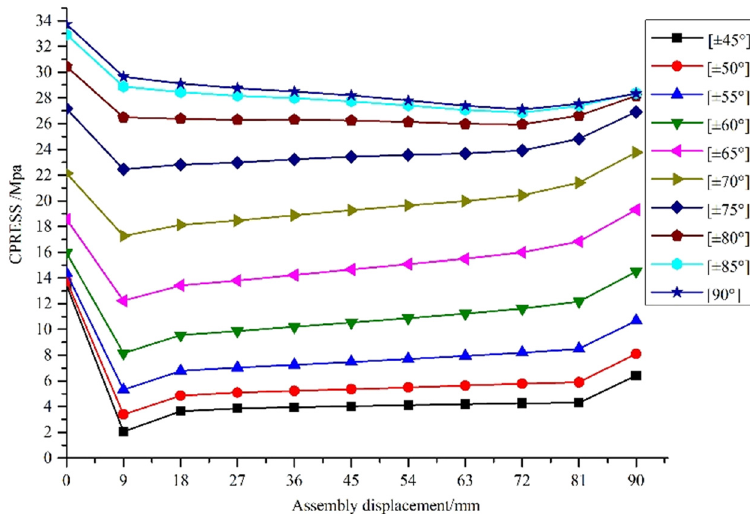
Figure 8: Distribution of contact surface stress values along the path at di ff erent angles.